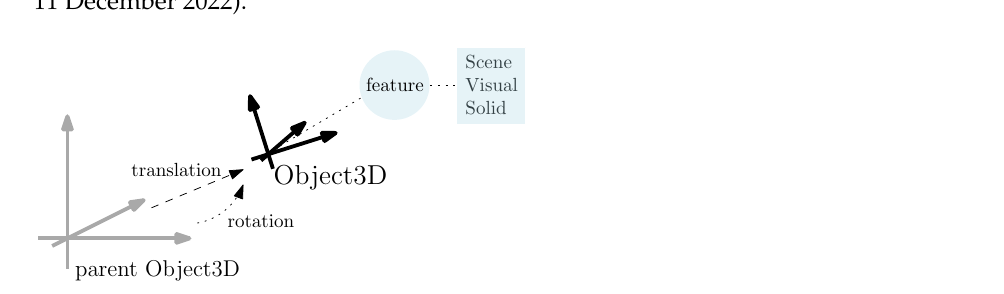
Figure 8. Object3D defined relative to its parent with translation and rotation. An Object3D can have one optional feature: Scene, Visual or